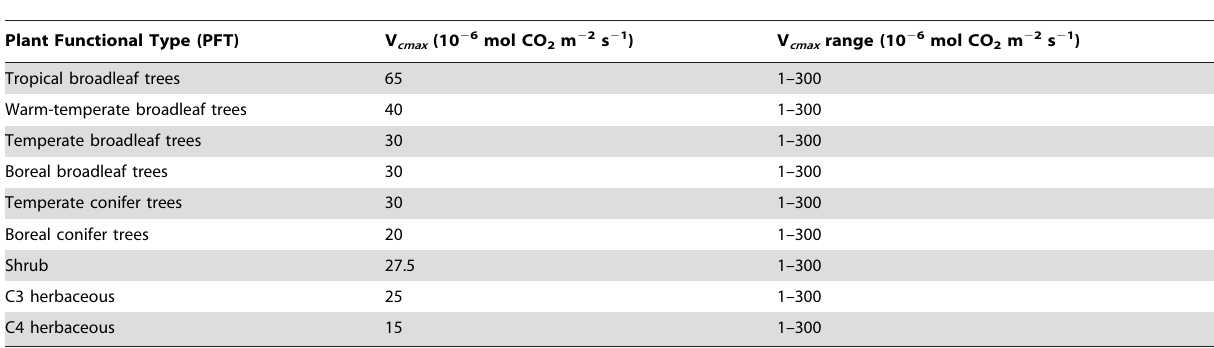
Table 1. The values of V cmax set in the IBIS model and the initial range of MCMC inversion.